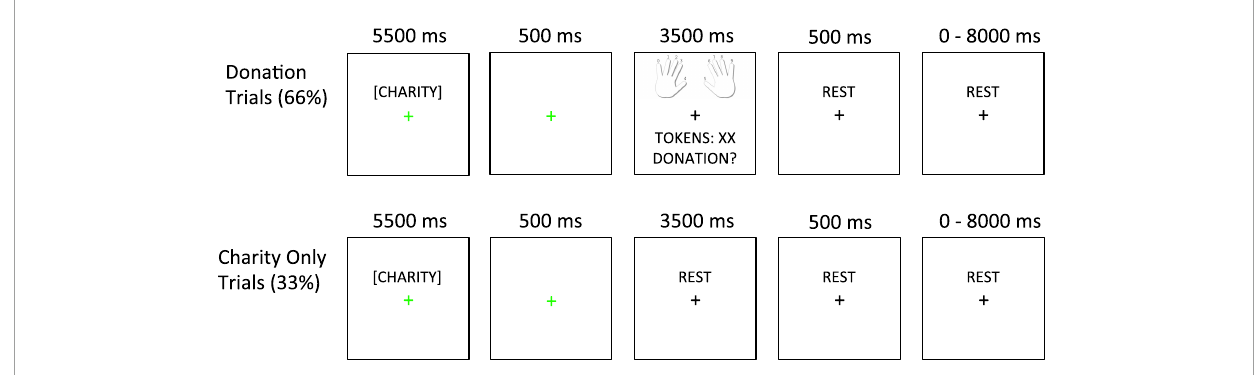
FIGURE1 Task design. In Donation trials (66%), the charity description was followed by a 500 ms fixation slide. Next, the decision slide appeared (showing finger-response mappings, tokens earned, and the donation option). In Charity Only trials (33%), the charity description and 500 ms fixation slides were followed by an additional rest period whose duration matched that of the decision slide (3,500 ms). The fixation cursor always changed to green to indicate the onset of the charity description and then back to black after the first fixation